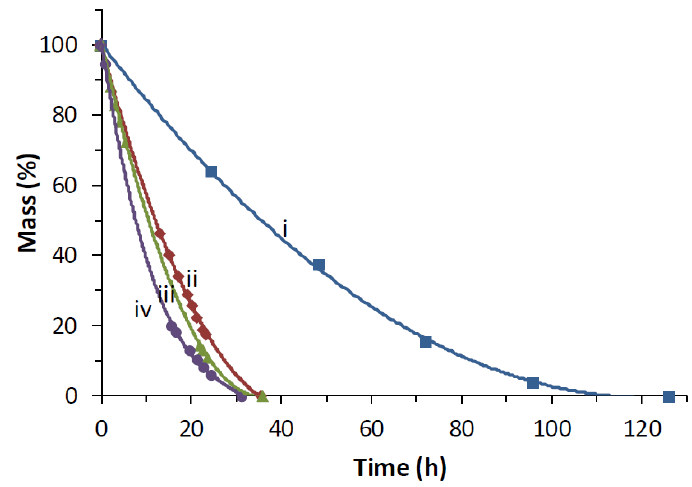
Figure 3. Reaction times at different temperatures, expressed as the percentage remaining of the initial mass of gold as a function of time: ( i ) 281 mg pellet at room temperature; ( ii ) 268 mg pellet at 50 °C; ( iii ) 319 mg pellet at 60 °C; ( iv ) 357 mg pellet at 70 °C. Note: pellets were used as-received from the supplier hence the range of masses used. The effect of surface area of the gold pellet is also an important factor influencing reaction times. The data shown in Figure 3 were obtained using reasonably spherical (as purchased) gold pellets. Mechanical flattening of the gold pellets to thicknesses <1 mm resulted in significantly shorter reaction times whereby the flattened pellets dissolved in ~12 h at 50 °C ( ca . 35 h for spherical pellets). However, care needs to be taken to prevent any metallic contamination of the gold during the flattening process. This may be accomplished by placing the gold between layers of cotton fabric or sheets of polycarbonate prior to the mechanical flattening process.